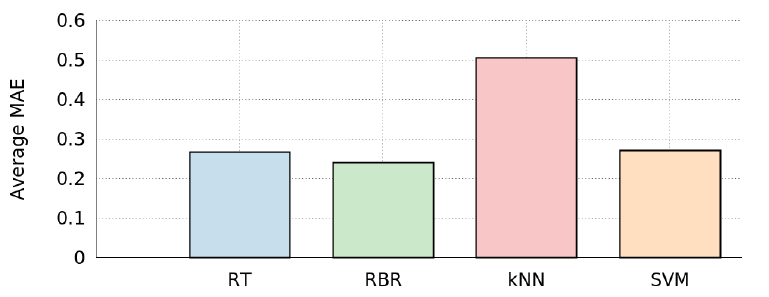
Figure 9. Average Mean Absolute Error (MAE) of the EtEQ